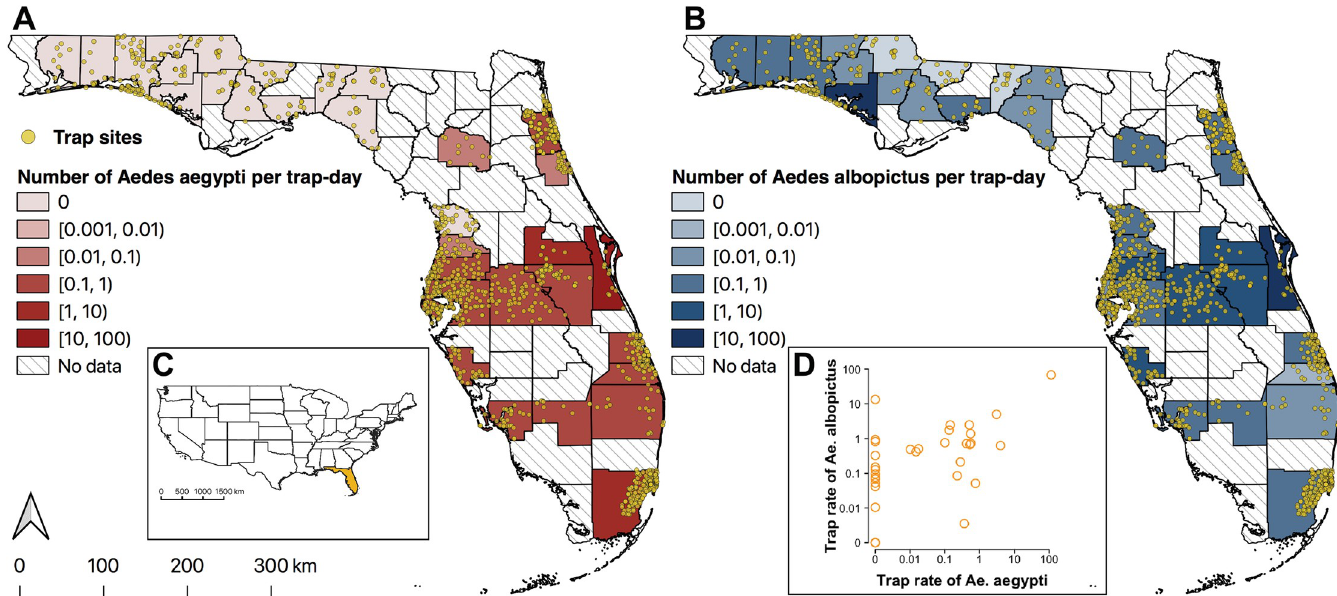
Fig 1. Locations of traps and geographic variation in abundance of Aedes aegypti (A) and Aedes albopictus (B) in Florida. Color (red for Ae . aegypti , blue for Ae . albopictus ) indicates mean abundance per trap day in each county. Diagonal lines indicate counties without data. Inset (C) shows the location of Florida (orange) in the contiguous US. Plot (D) shows Ae . aegypti versus Ae . albopictus abundances in each county. Maps produced using QGIS Version 3.0.2 (QGIS Development Team, 2018). Source of shapefile: Southwest Florida Water Management District (https://geodata.myflorida.com/datasets/swfwmd::florida-counties).